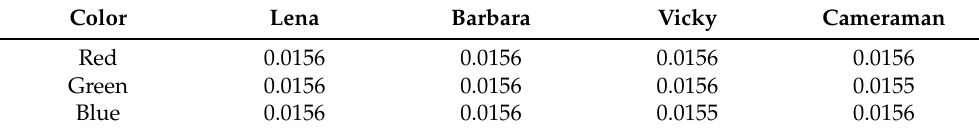
Table 8. Energy of Figure 1 images after encryption.